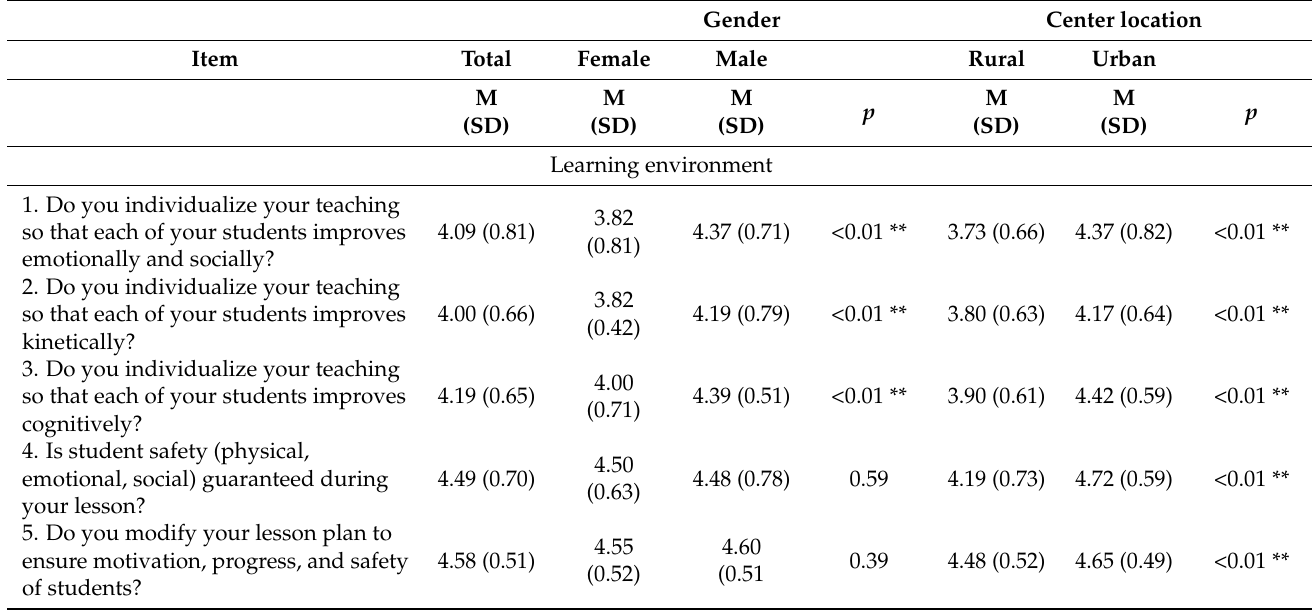
Table 2. Descriptive statistics and differences in SETEQ-PE questionnaire items based on gender and center